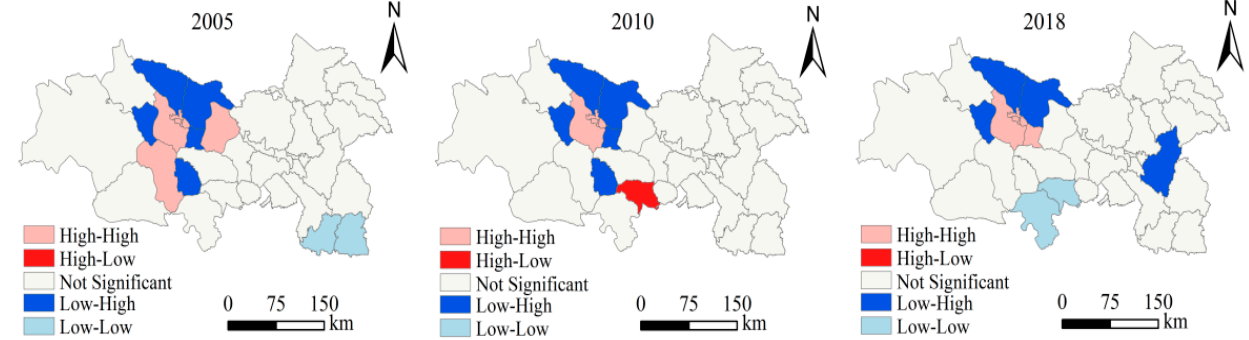
Figure 8. Spatial correlation type diagram of CCD of CLUB in the LXUA.